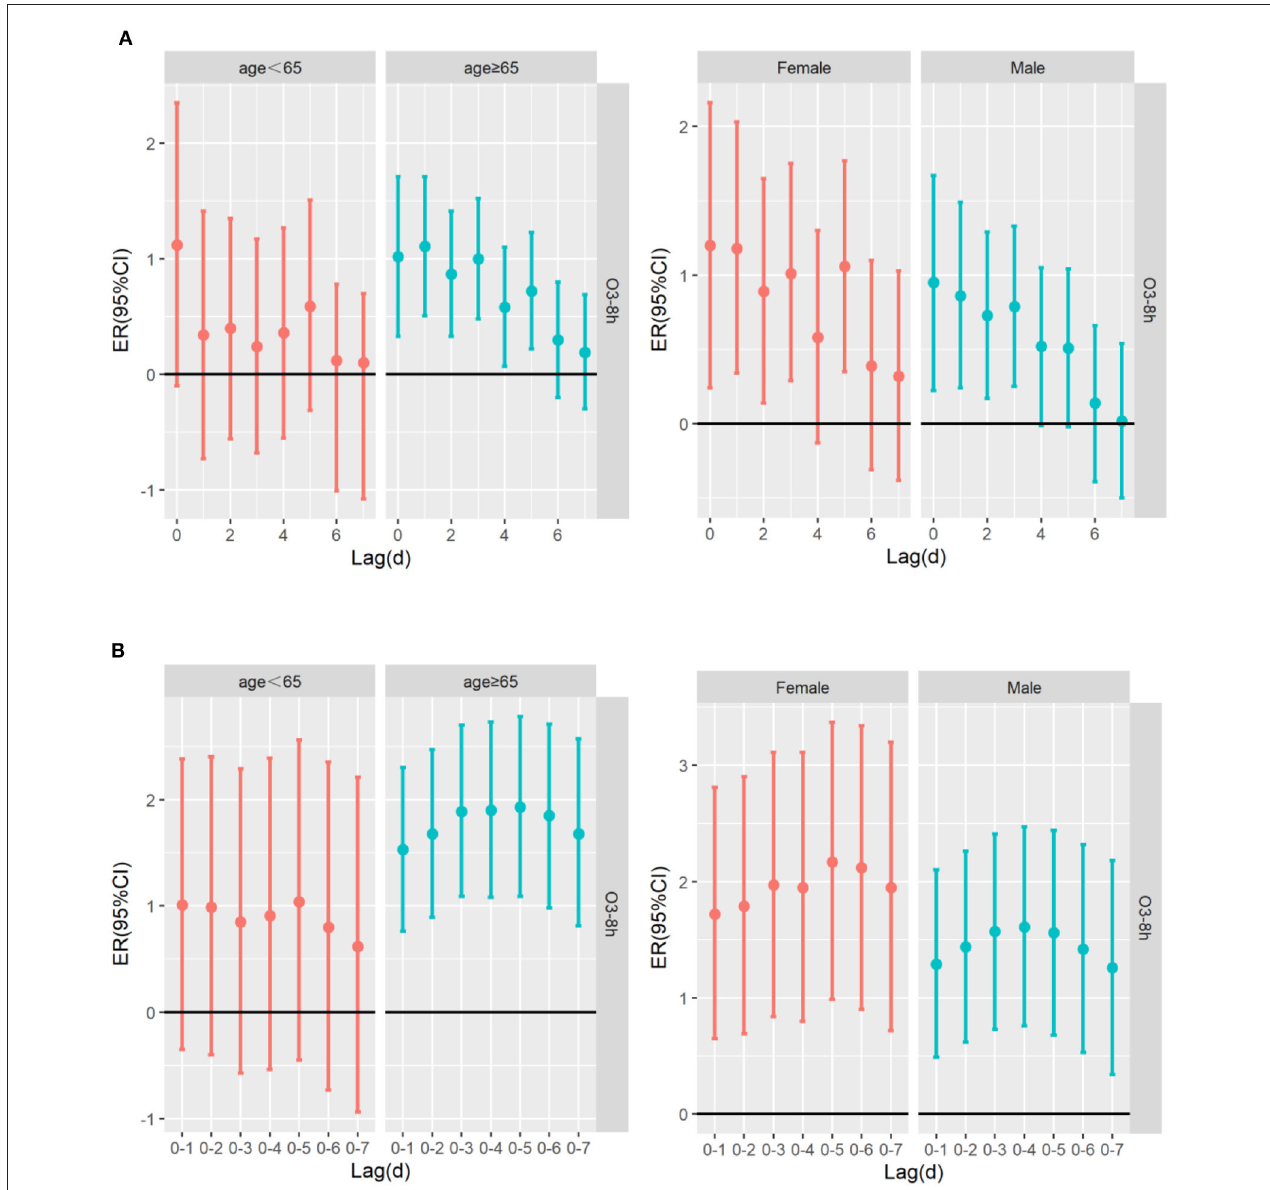
FIGURE 5 | The ER (95%CI) of respiratory mortality in age and sex lag-response relationship associated with 10 µ g/m 3 increase of O 3 -8h concentration; (A) The risks of respiratory mortality associated with 10 µ g/m 3 increase of O 3 -8h; (B) The cumulative risks of respiratory mortality associated with 10 µ g/m 3 increase of O 3